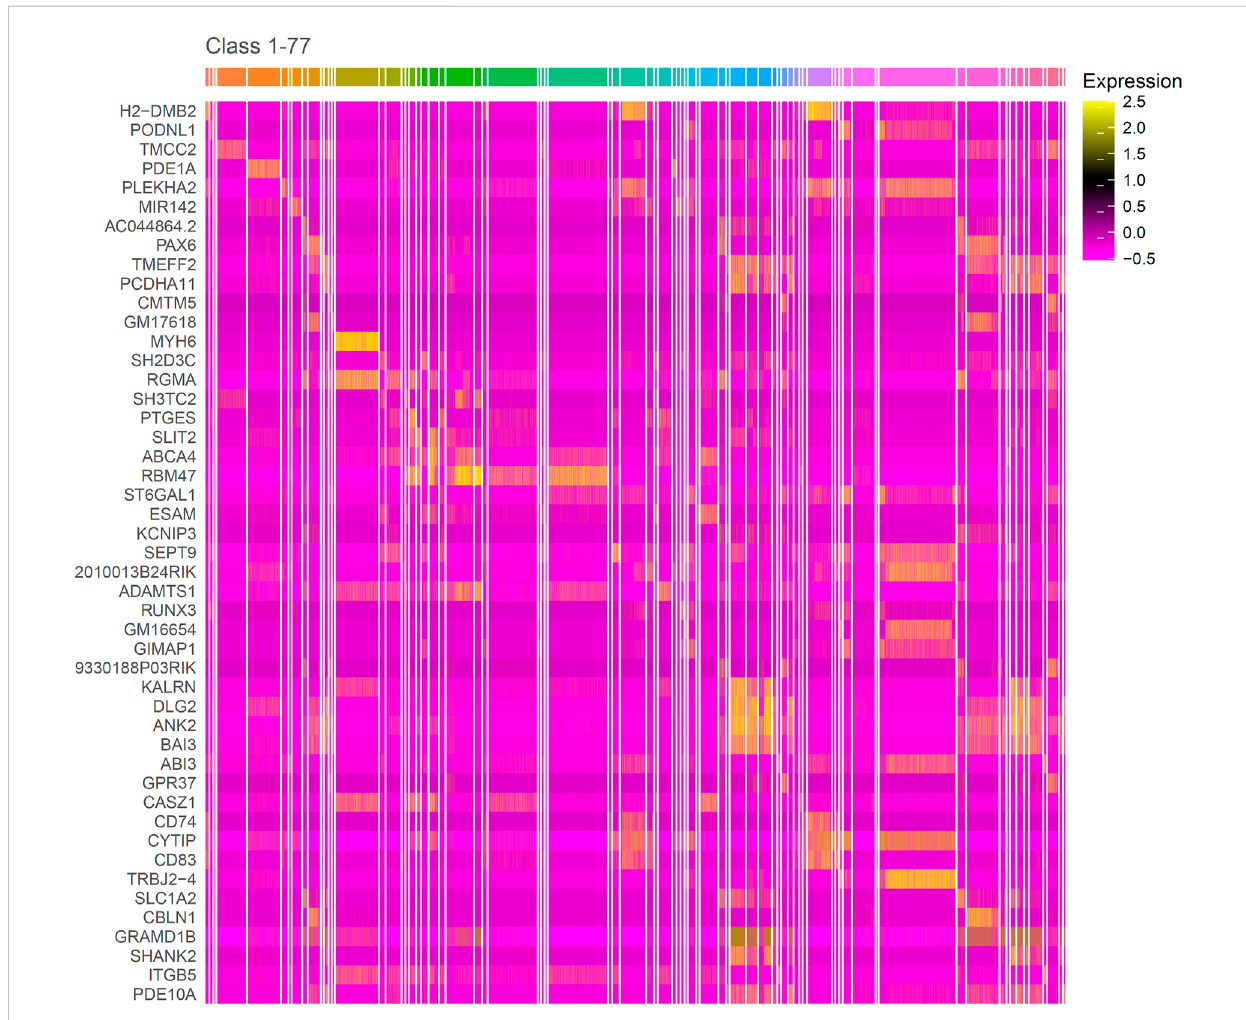
FIGURE 4 HeatmapofgenesintheoptimalgenesubsetobtainedbyMCFSandIFS.Thebrightcolorcorrespondingtothegeneintheheatmapinsomeclasses indicates that this gene is transcriptionally active in these classes. Similarly, if the gene is darker in the class, then it is transcriptionally inactive in this class. The marker genes identi fi ed by this research can distinguish different cell